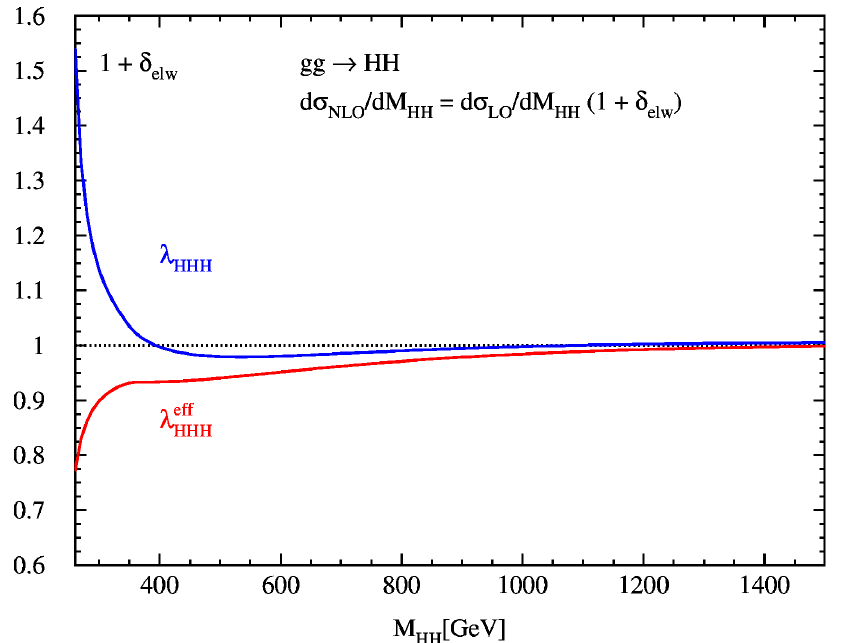
Figure 5 . The relative top-Yukawa-induced electroweak corrections to the differential Higgs-pair production cross section as a function of the invariant Higgs-pair mass M HH . The blue curve shows the electroweak correction factor using the LO trilinear Higgs coupling of eq. (2.5) and the red curve the corrections factor involving the effective coupling λ eff HHH of eq. (3.11). The black dotted line at the value 1 is inserted to guide the eye. The electroweak corrections factor is independent of the hadronic c.m. energy and scale choices in the QCD part of the differential cross section dσ/dM HH so that it is valid for any hadronic energy as a pure rescaling